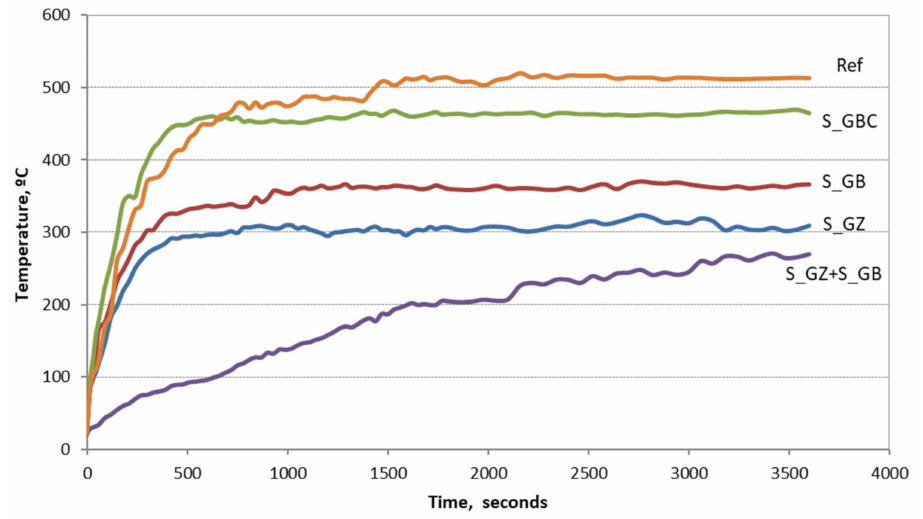
Figure 9. The evolution of the temperature of “cold” face vs. time for the plates covered with studied silicate